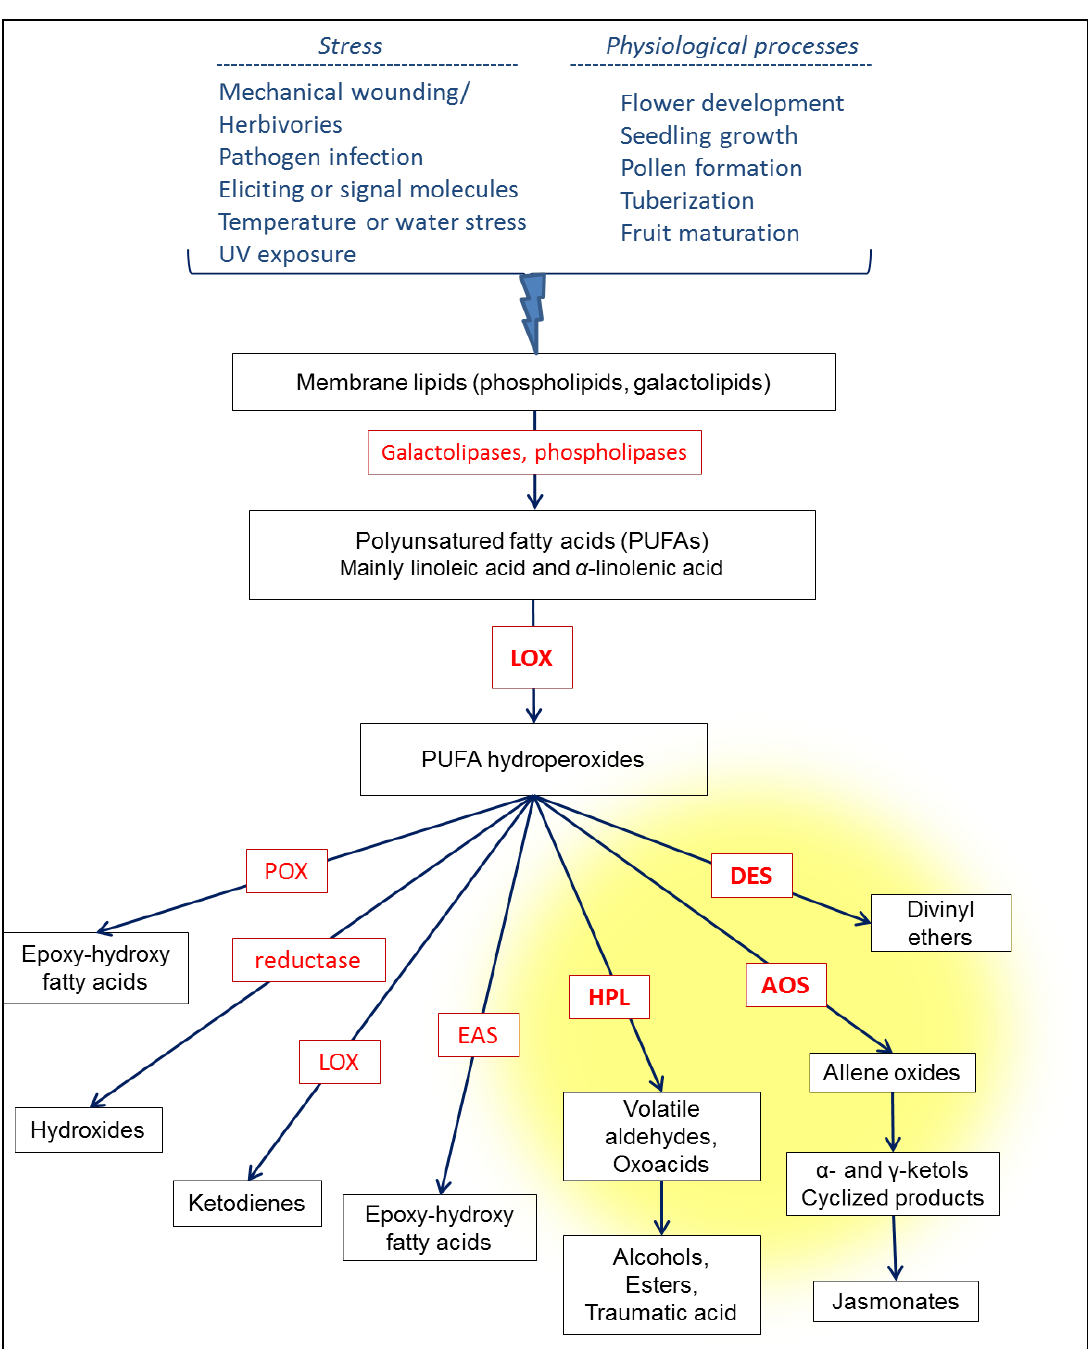
Figure 1. The lipoxygenase pathway in plants. The substrates and products of the reactions are represented in black, and the enzymes involved appear in red (allene oxide synthase (AOS); divinyl ether synthase (DES); epoxide alcohol synthase (EAS); hydroperoxide lyase (HPL); lipoxygenase (LOX); and peroxygenase (POX)). The reactions catalyzed by the enzymes of the CYP74 subfamily are stained yellow.